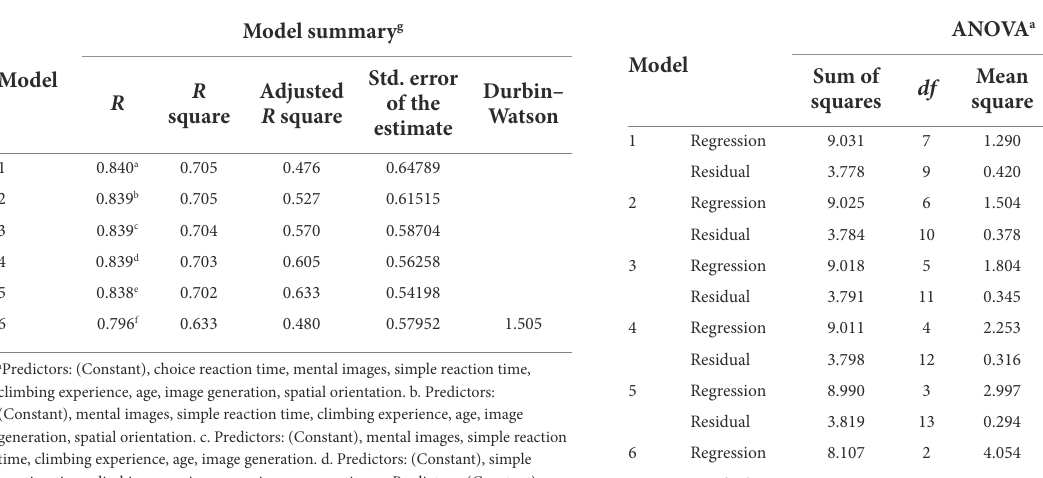
TABLE 9 Model summary for predicting red-point performance. TABLE 10 ANOVA for predicting red-point